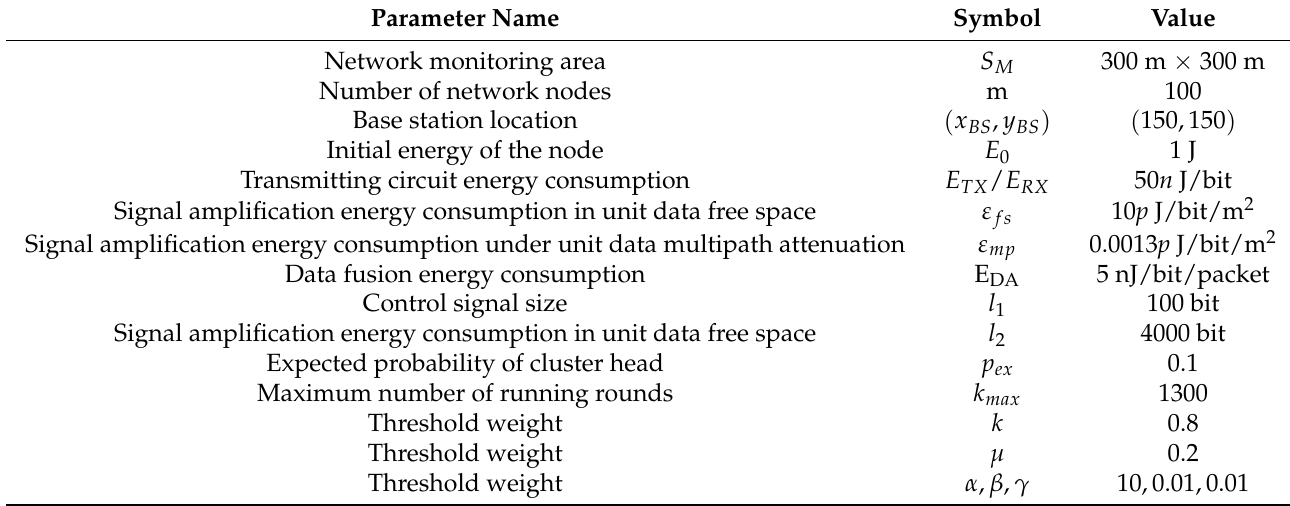
Table 1. Simulation